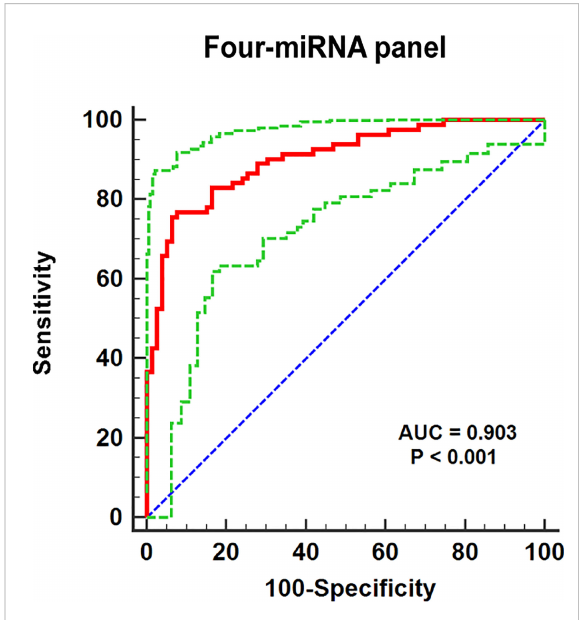
FIGURE 4 The ROC curve evaluation for the four-miRNA panel. This four- miRNA panel contained miR-1-3p, miR-155-5p, miR-200b-3p, and miR-224-5p, and the AUC for the panel was 0.903 (95% CI: 0.847 – 0.944; p< 0.001; sensitivity = 75.61%, speci fi city =